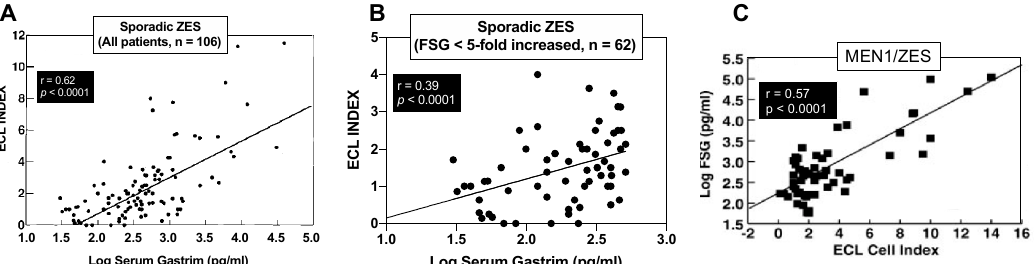
Figure 2. Correlations between the fasting serum gastrin levels (FSG) and the gastric enterochroma ffi n- like cells (ECL) cell proliferative index in ZES patients from two NIH studies. ( A , B ) show data from patients with sporadic ZES ( n = 106) whereas ( C ) shows data from a study of patients ( n = 57) with MEN1 / ZES. All patients had multiple gastric biopsies and the proliferative ECL index was calculated from the degree of ECL changes in all biopsies and correlated with the FSG level. In ( A ) all 106 sporadic disease patients were included (90 active, 16 cured) and in ( B ), only patients with FSG levels < 5-fold increased were included, which are levels overlapping with those seen in nonZES patients taking chronic PPIs. ( C ) shows the data from the 57 patients with MEN1 / ZES. In all cases, there is a highly significant correlation of the FSG levels with the degree of ECL cell proliferative change. In ( B ), the data shows there is no threshold for gastrin’s ability to stimulate ECL cell proliferative e ff ects as was proposed in the past. Figures are drawn from the data in